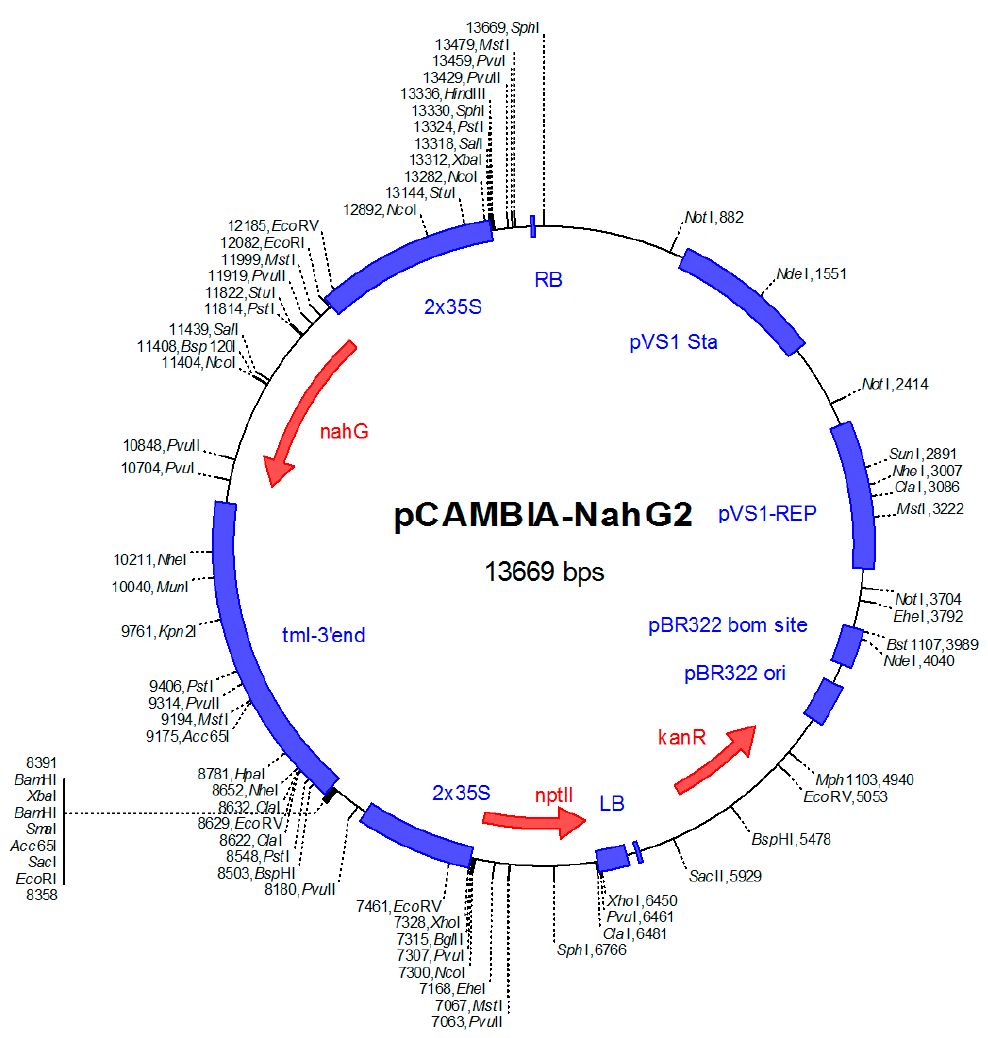
Figure 7. Structure of binary plasmid pCAMBIA2300 containing the NahG gene. A fragment of double 35S- NahG gene-tml-3´end from pCIB200- NahG was inserted into pCAMBIA2300 by using Xba I restriction enzyme recognition site. Kanamycin-resistance ( kan R) marker was the selectable marker used for transformed plant cells. Neomycin phototransferase II ( npt II) was the selectable marker for plant transformation.